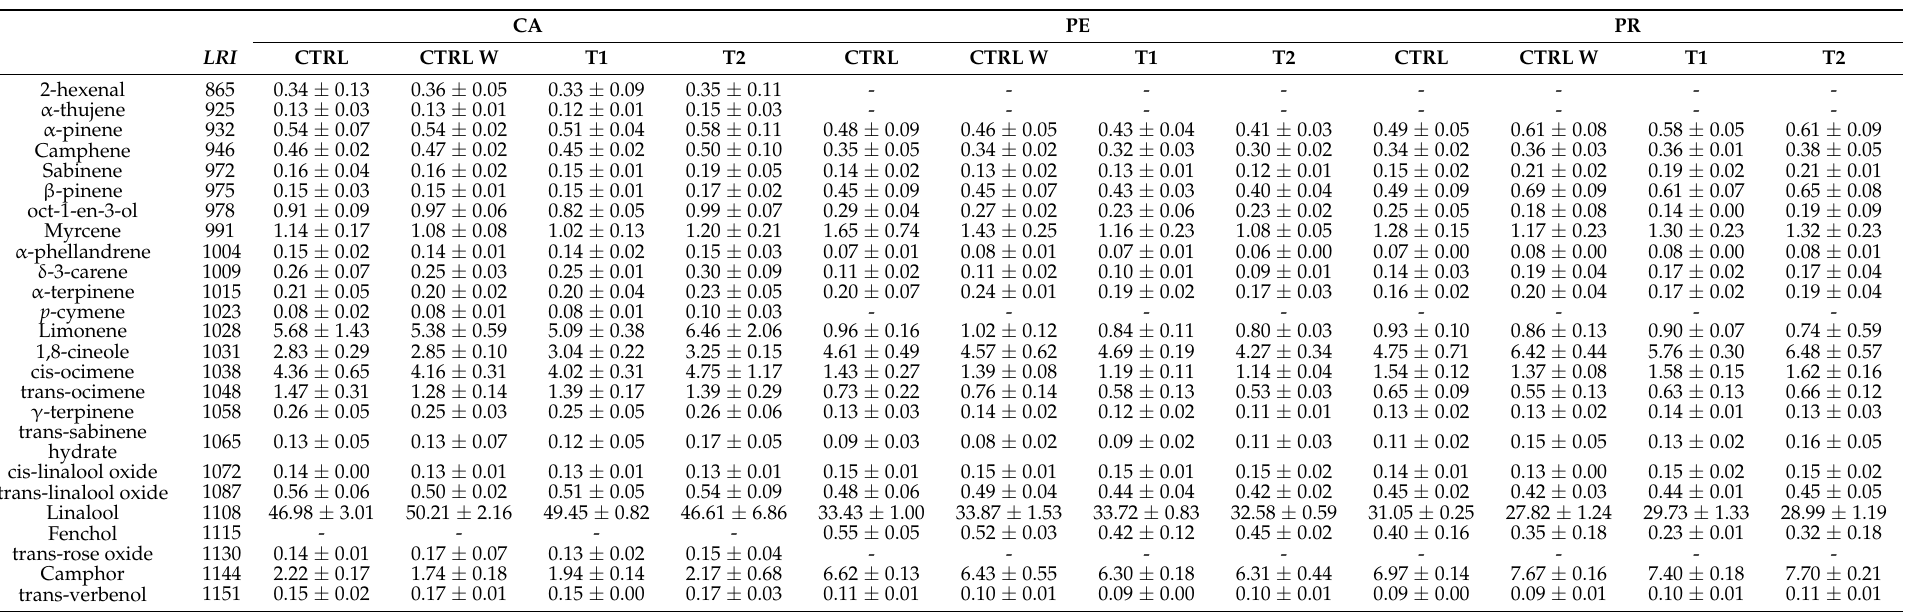
Table 2. Chemical composition % of EOs expressed as mean ± standard